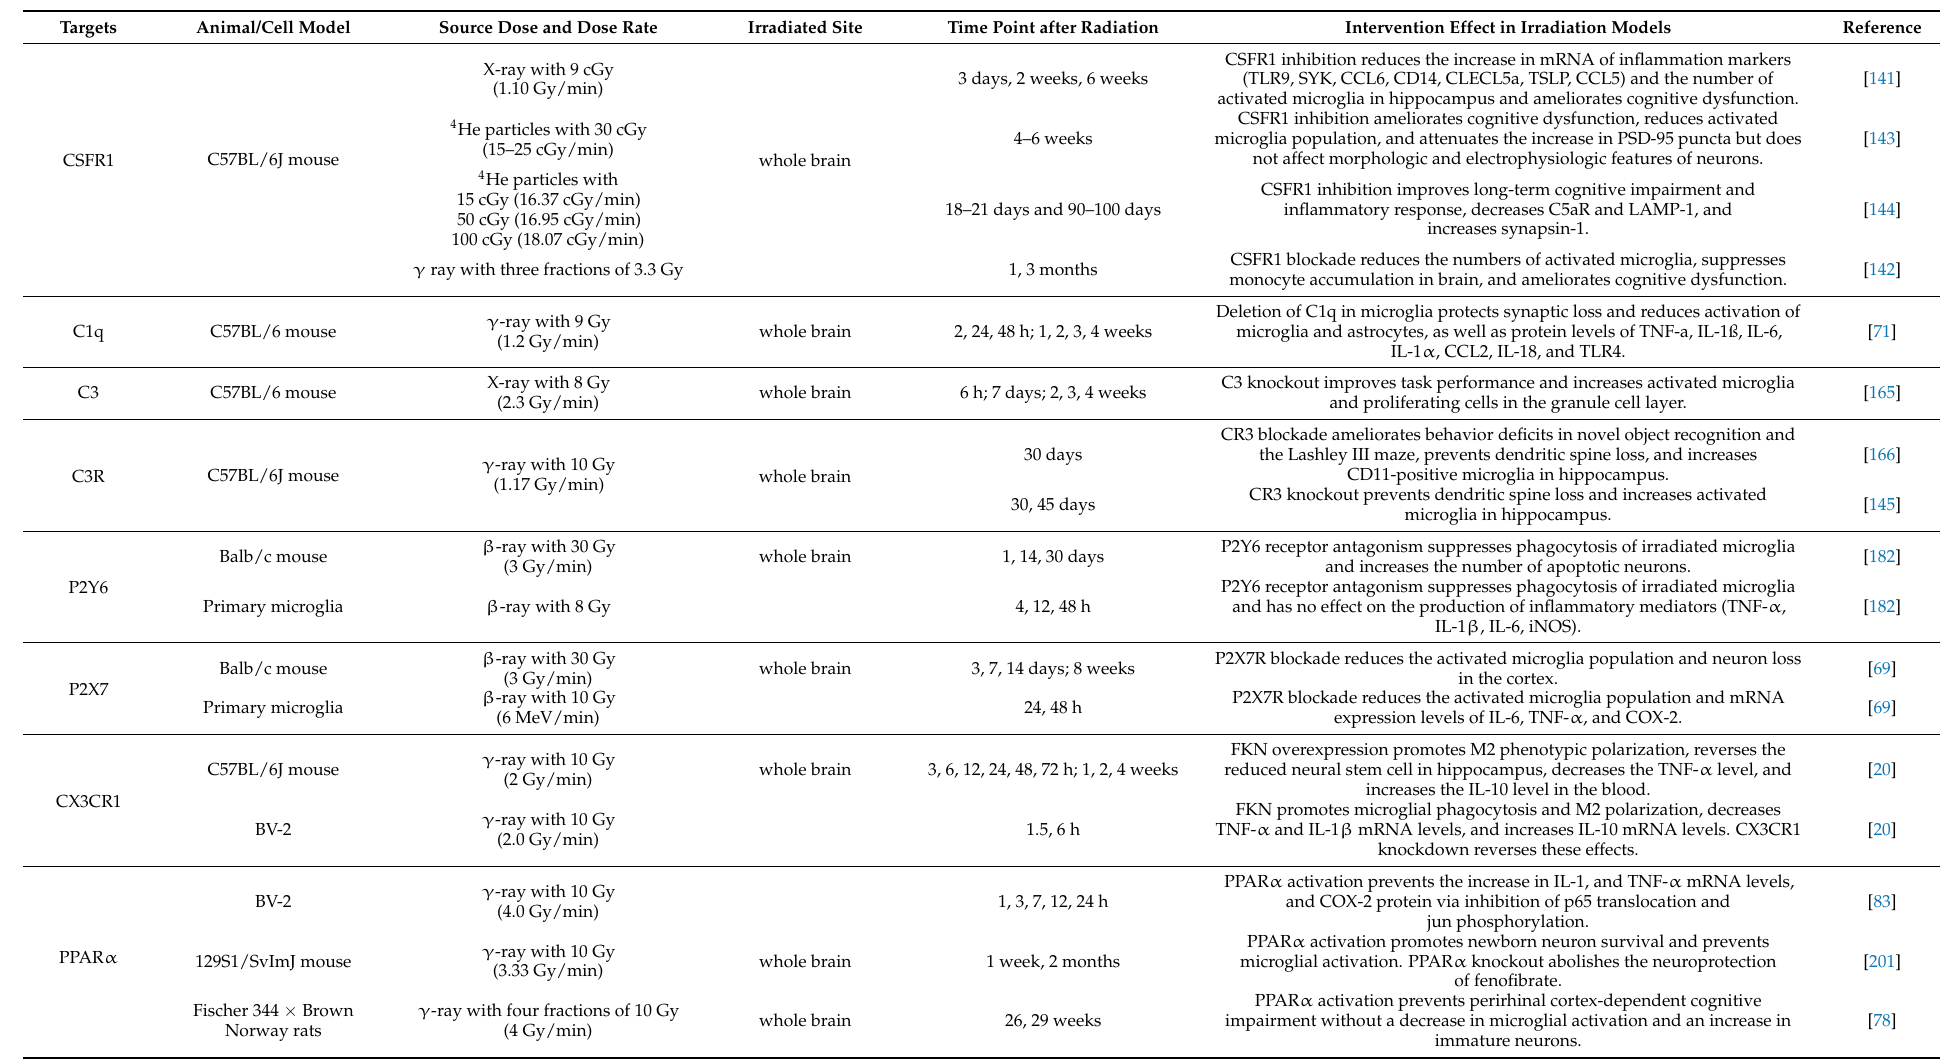
Table 1. Radioprotective effect of targeting different molecules in microglia in radiation-induced brain injury